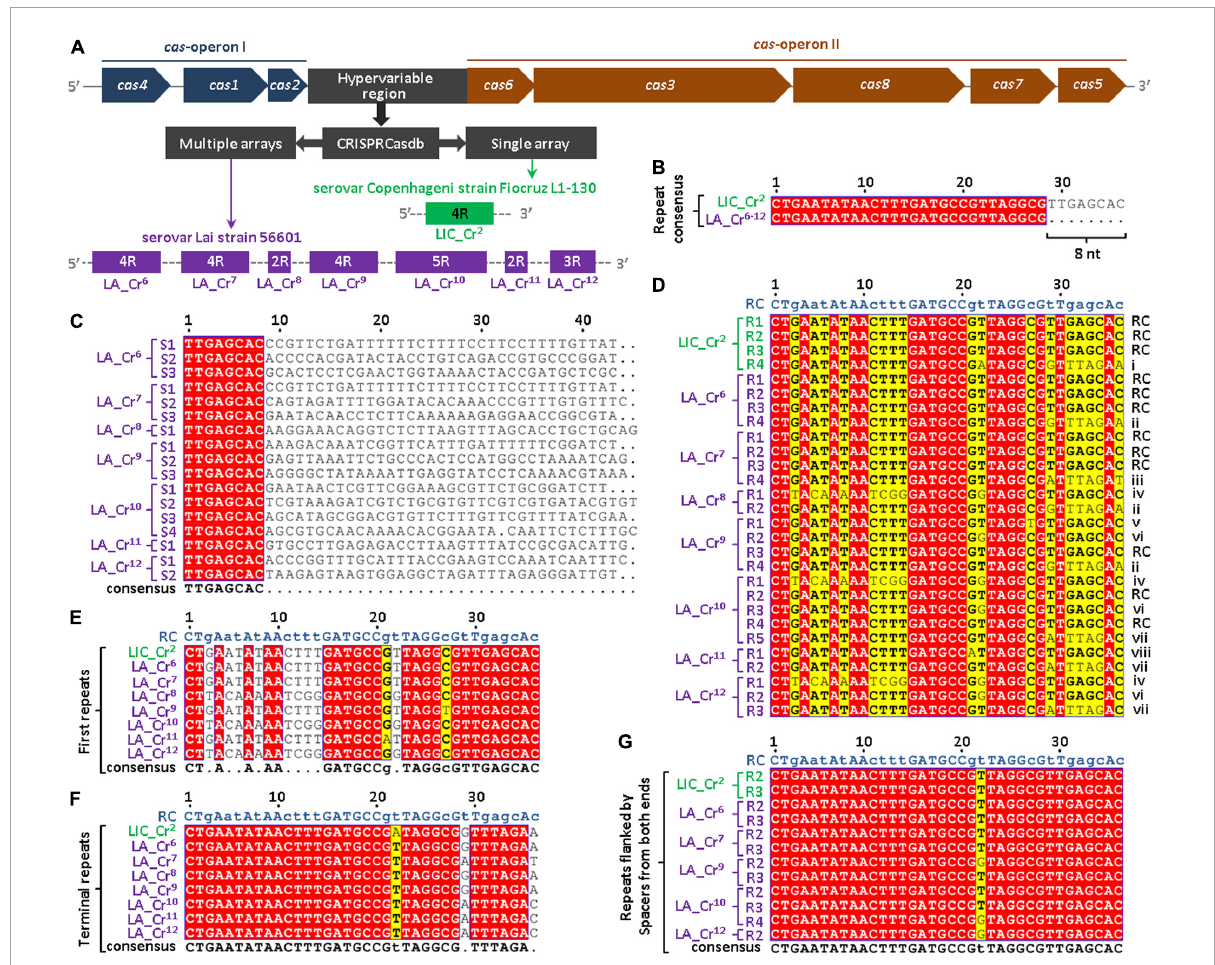
FIGURE1 Multiple sequence alignments (MSA) of spacers and repeats of CRISPRs predicted in the I-B locus of L. interrogans serovar Lai strain 56601. (A) CRISPRCasdb database analysis of the hypervariable region in I-B locus of serovar Lai. The generalized architecture of the CRISPR-Cas I-B locus harbored by different strains of L. interrogans shows the hypervariable region that contains single or multiple CRISPRs, as observed in serovar Copenhageni (LIC_Cr 2 ; Prakash and Kumar, 2021) or Lai (LA_Cr 6 - 12 ; in this study), respectively. Each CRISPR is represented by the number of associated repeats predicted by the CRISPRCasdb. (B) Nucleotide alignment of repeat consensus sequences of LIC_Cr 2 and LA_Cr 6 - 12 . Nucleotide alignment between database-defined repeat consensus of LIC_Cr 2 and LA_Cr 6 - 12 showed a deficit of 8 nt at the 3 (cid:48) end of LA_Cr 6 - 12 repeats. (C) MSA of spacer sequences. Spacer sequences ( n = 17) of CRISPRs I-B (LA_Cr 6 - 12 ) in serovar Lai were retrieved from CRISPRCasdb and aligned using Clustal Omega. The alignment shows conserved 8 nt sequences at the 5 (cid:48) end of each spacer (red filled box). (D) MSA of repeat sequences. Previously characterized and manually curated repeat sequences of CRISPRs I-B in serovar Copenhageni (LIC_Cr 2 ) and Lai (LA_Cr 6 - 12 ), respectively, were aligned. The alignment shows conservation or polymorphism in the 1st to 36th nucleotide position of each repeat. Repeat consensus (RC) and repeat variants (i-viii) are indicated at the right to the respective sequences in the alignment. MSA of first repeats (E) , terminal repeats (F) , and repeats that are flanked by spacers at both ends (G) . Red and yellow colored nucleotides in the alignments represent 100% and more than 70% conservation, respectively, at that position among total sequences. Consensus sequences of each MSA were shown below the alignment where upper and lower cases denote conserved and semi-conserved nucleotides,